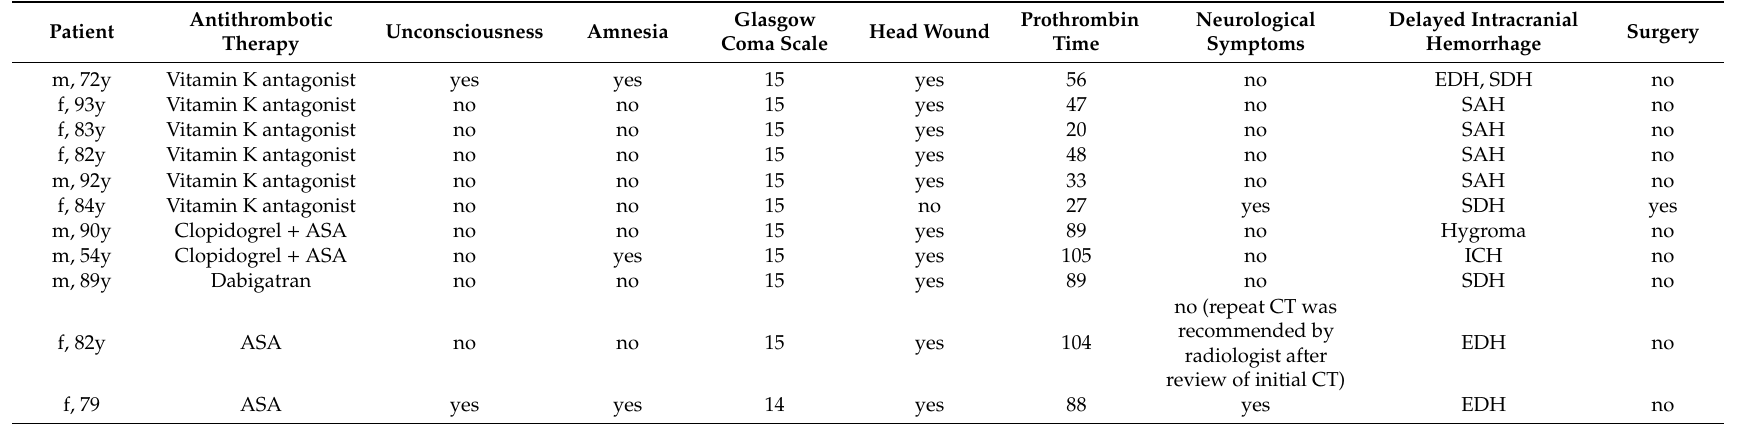
Table 2. Characteristics of patients with delayed intracranial hemorrhage in our study population including sex and age, antithrombotic therapy, reported unconsciousness and amnesia, prothrombin time at admission, neurological symptoms during in-hospital observation, type of delayed intracranial hemorrhage (EDH = epidural hematoma, SDH = subdural hematoma, SAH = subarachnoid hematoma, ICH = intracerebral hematoma) and necessity of surgery. ASA = acetylsalicylic